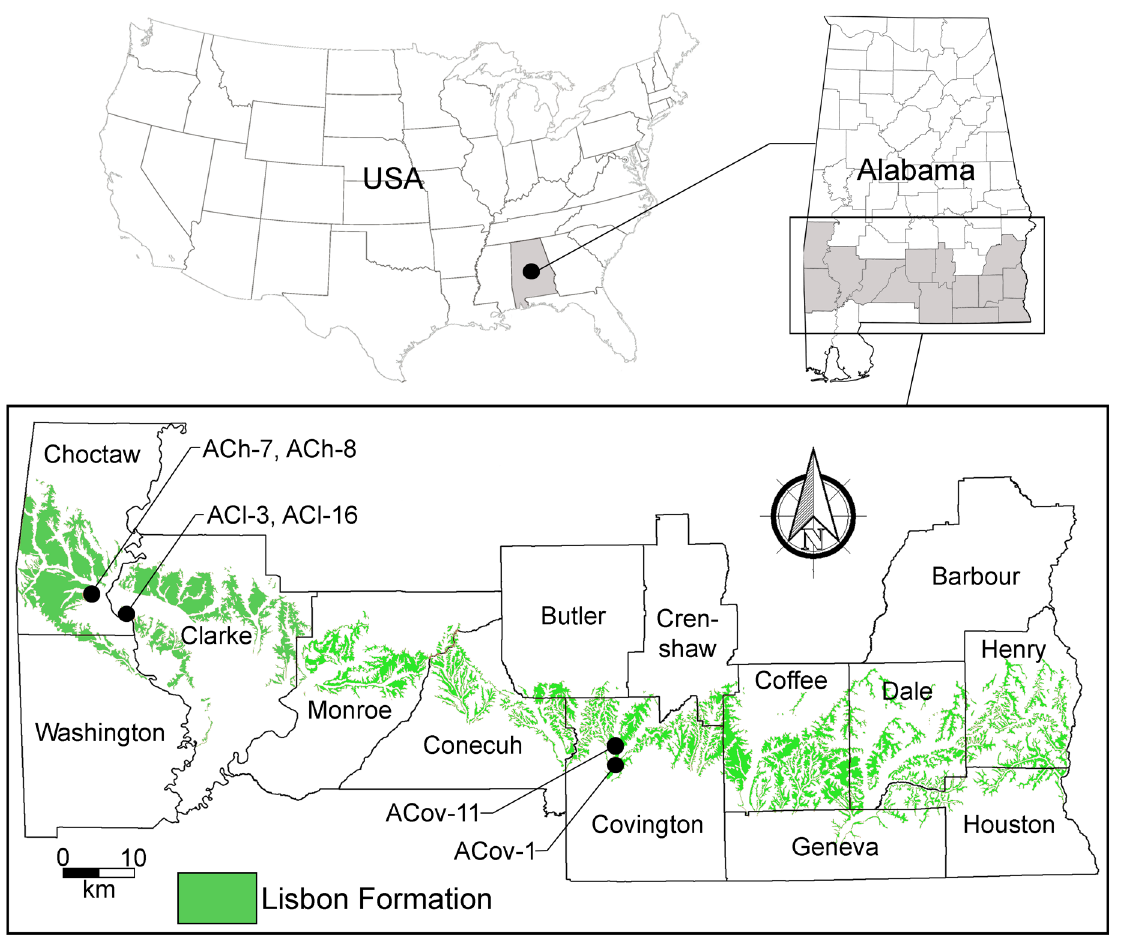
Fig. 3. Lisbon Formation surface exposures in Alabama, with sampled localities indicated by closed